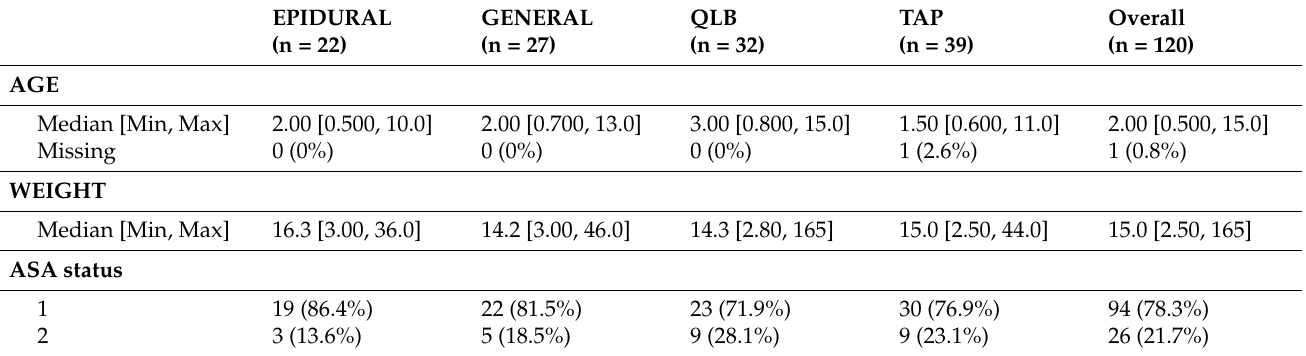
Table 1. Demographic data showing number and percentage of gender, age, weight and ASA status.